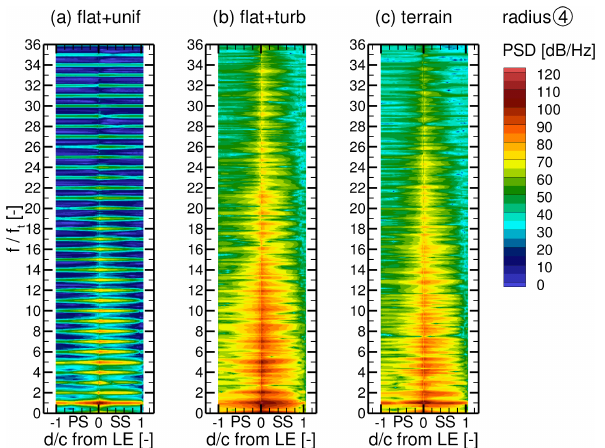
Figure 24. Power spectral density of surface pressure fluctuations on a line around the blade at radius (4) for all cases (a) – (c)